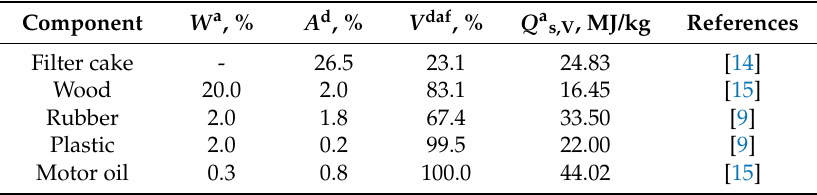
Table 1. Properties of fuel components. Proximate